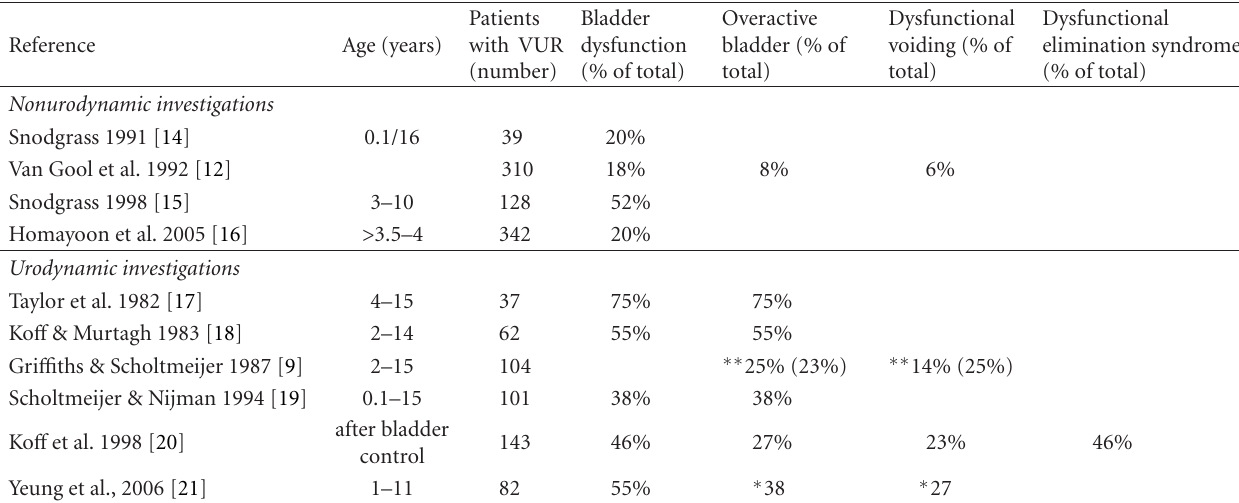
Table 1: Prevalence of bladder dysfunction in patients with